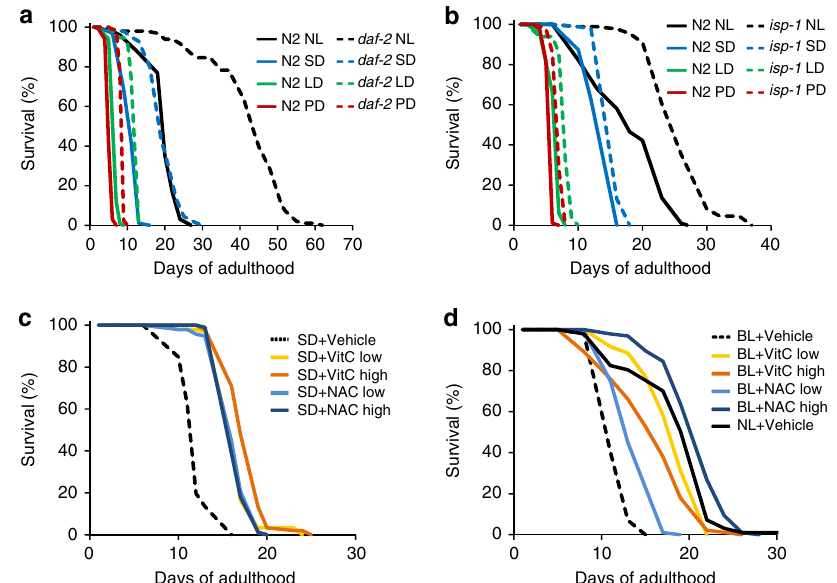
Fig. 6 Increasing defense mechanisms protects C. elegans from light toxicity. a Lifespan of daf-2 (e1370) mutants versus N2 worms under PD, LD, SD, and NL photoperiods. b Lifespan of isp-1(qm150) mutants versus N2 worms under PD, LD, SD, and NL photoperiods. c , d Lifespan of N2 worms supplemented with low (5 mM) or high (10 mM) concentration of VitC or NAC versus vehicle under SD condition ( c ) or bench light (BL) condition ( d ); NL+ vehicle was used as additional